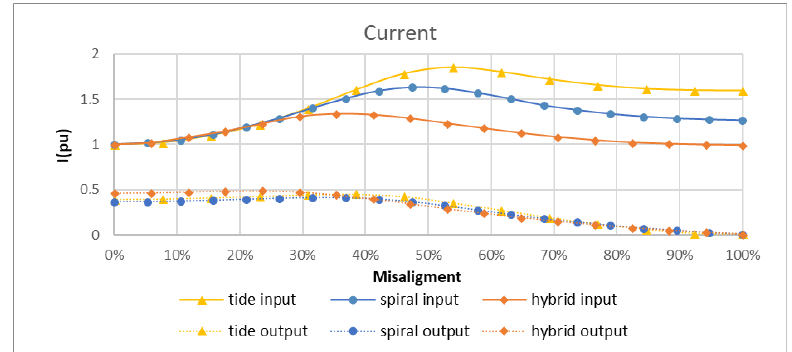
Figure 24. Measured current for primary compensation with resistive load.